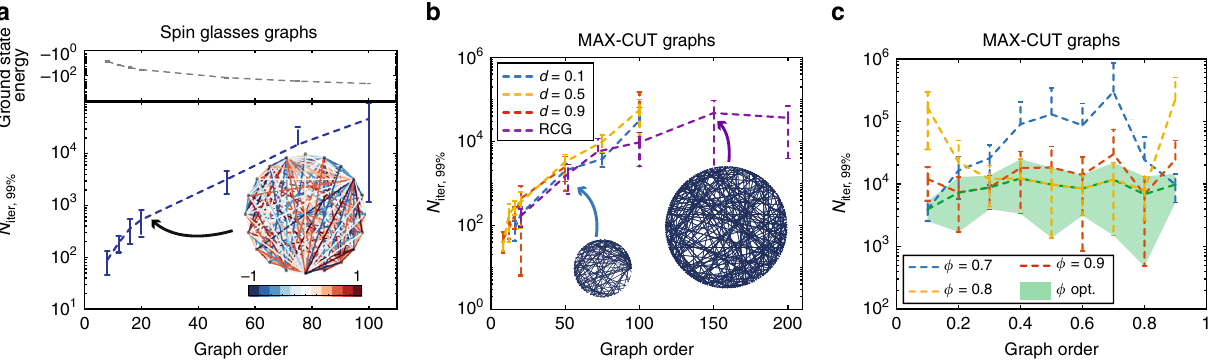
Fig. 2 Scaling performance of the PRIS. ( a , top) Ground state energy versus graph order of random spin glasses. A sample graph is shown as an inset in ( a , bottom): a fully-connected spin glass with uniformly-distributed continuous couplings in [ − 1, 1]. N iter, 99% versus graph size for spin glasses ( a , bottom) and MAX-CUT graphs ( b ). c N iter, 99% versus graph density for MAX-CUT graphs and N = 75. The graph density is de fi ned as d = 2 ∣ E ∣∕ ( N ( N − 1)), ∣ E ∣ being the number of undirected edges. RCG denotes Random Cubic Graphs, for which ∣ E ∣ = 3 N ∕ 2. Ground states are determined with the exact solver BiqMac 57 (see Methods section). In this analysis, we set α = 0, and for each set of density and graph order we ran 10 graph instances 1000 times. The number of iterations to fi nd the ground state is measured for each run and N iter, q is de fi ned as the q -th quantile of the measured